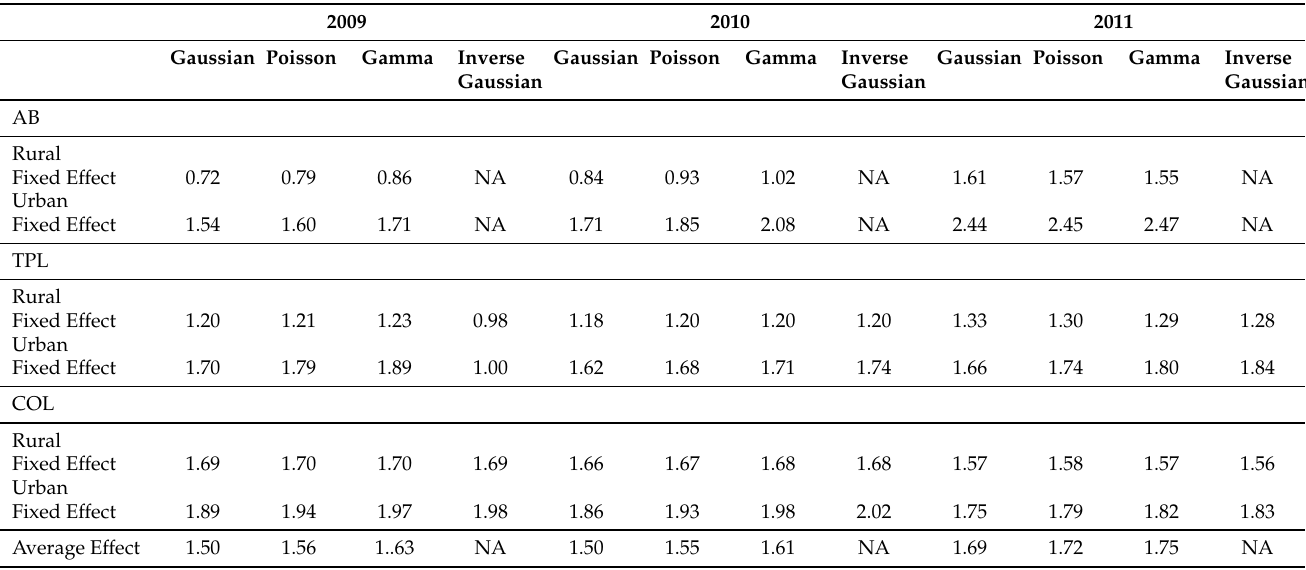
Table 8. The fixed effect estimates for DR and CLASS, separated by year, coverages and region, obtained from the three-way GLM.